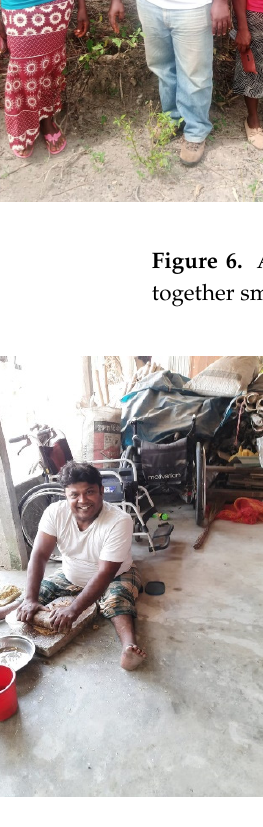
Figure 7. Alt-text: A man sitting on the floor, grinding spices and smiling, with his empty wheelchair behind him.